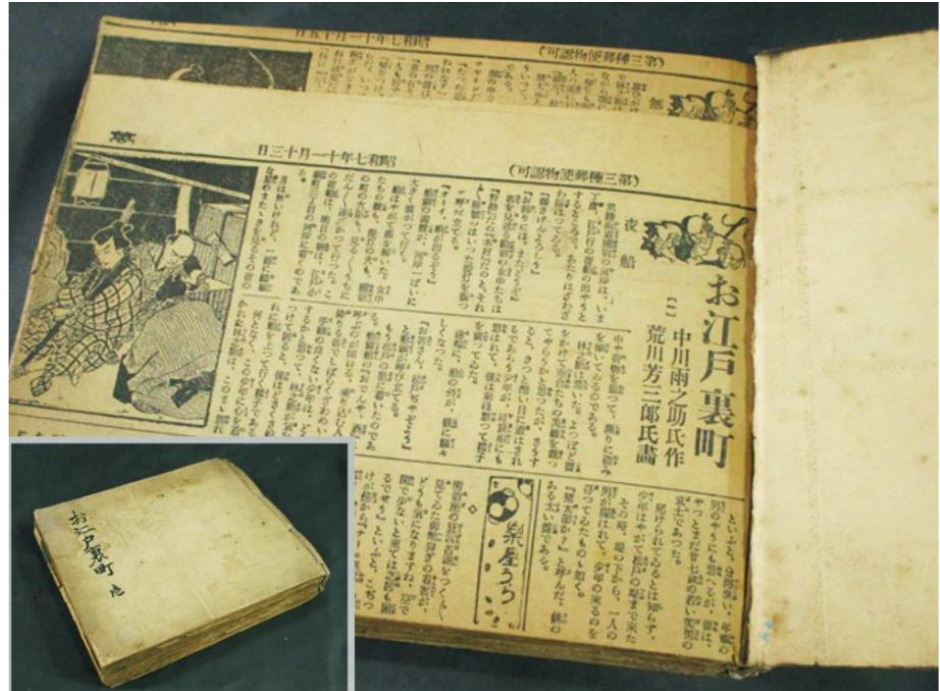
Figure 1. Reader-bound collection of The Slums of Edo installments. Image from Yahoo Auctions. Figure 1. Reader‑bound collection of The Slums of Edo installments. Image from Yahoo